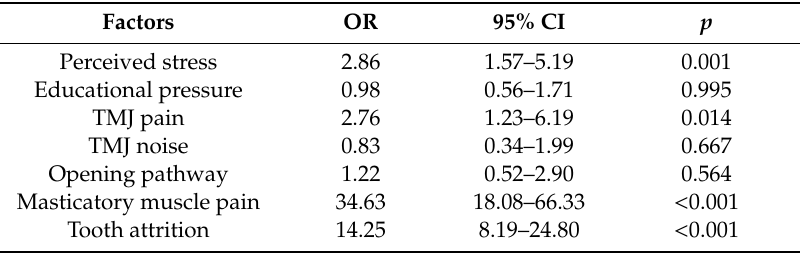
Table 4. Multiple logistic regression model of the relation between perceived stress, educational stress, temporomandibular joint (TMJ) pain, TMJ noise, masticatory muscle pain, abnormal opening pathway, and attrition the presence of bruxism.